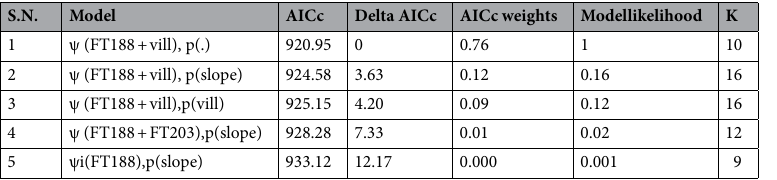
Table 1. Summary of top five models selected for multi-species occupancy of three ungulates in Uttarkashi